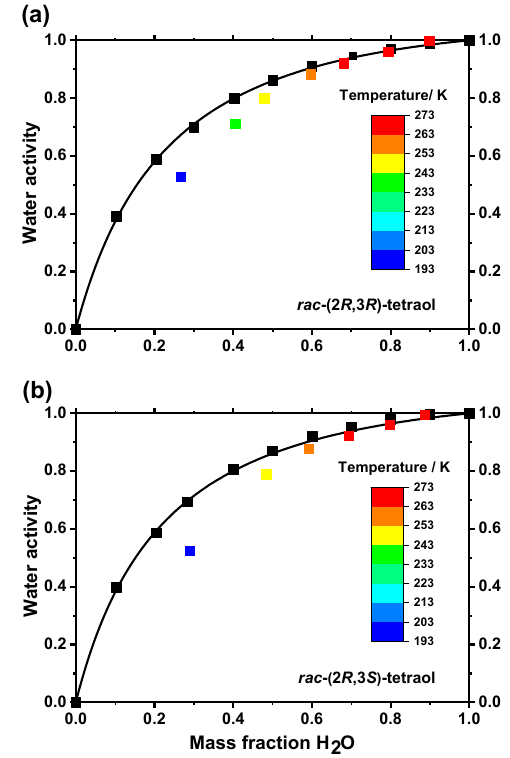
Figure 3. Measured water activity of mixtures of (a) rac -(2 R ,3 R) - tetraol with water and (b) rac -(2 R ,3 S) -tetraol with water at 298.15K (black squares) and at their ice melting points (colored squares). The curves are fits to the data: for details see main